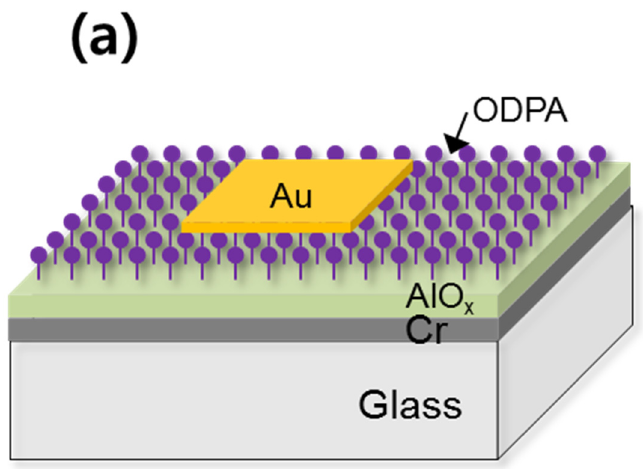
Figure 2. Cont. Figure 2. Cont.